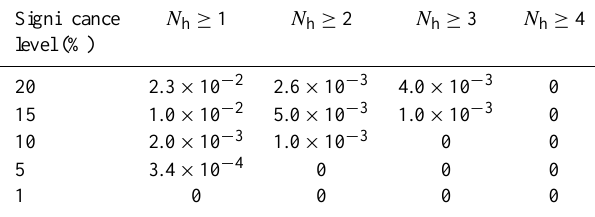
Table 1. Fraction of pointwise significance patches containing at least N h holes as a function of the pointwise significance level calculated from an ensemble of 200000 significance patches gen- erated from red-noise processes with fixed autocorrelation coeffi- cients equal to